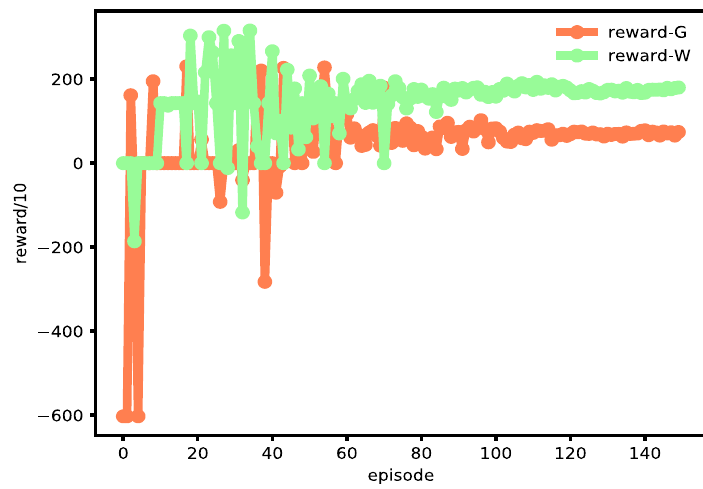
Figure 7. DDPG training convergence results.